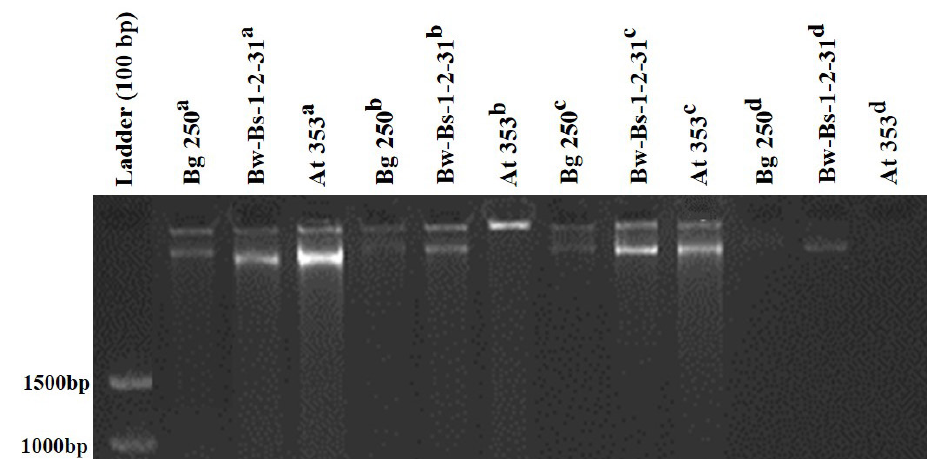
Figure 1: The agarosegel image of the genomic DNA extracted using four different methods/kits (1% agarose gel electrophoresis). Names of the rice varieties/lines are given on the top. A 100bp ladder was used in gel electrophoresis. a: CTAB method, b: modified CTAB method, c: Promega kit, d: Qiagen kit.